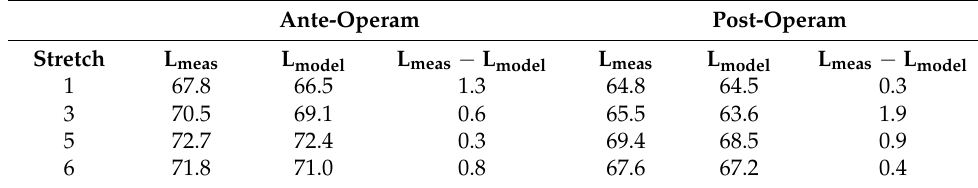
Table 11. L den values ante- and post-operam in Massarosa. Levels in dB(A). Ante-Operam Post-Operam Stretch L meas L model L meas − L model L meas L model